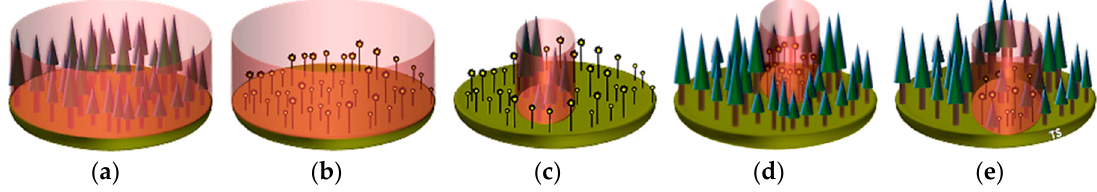
Figure 1. Schematic representation of the land cover types surveyed in this study. Forestland ( a ), non-forest semi-natural land ( b ), trees outside forest (TOF) ( c ), enclosed small open areas (encld-SOA) ( d ), encroaching small open areas (encrg-SOA) ( e ).